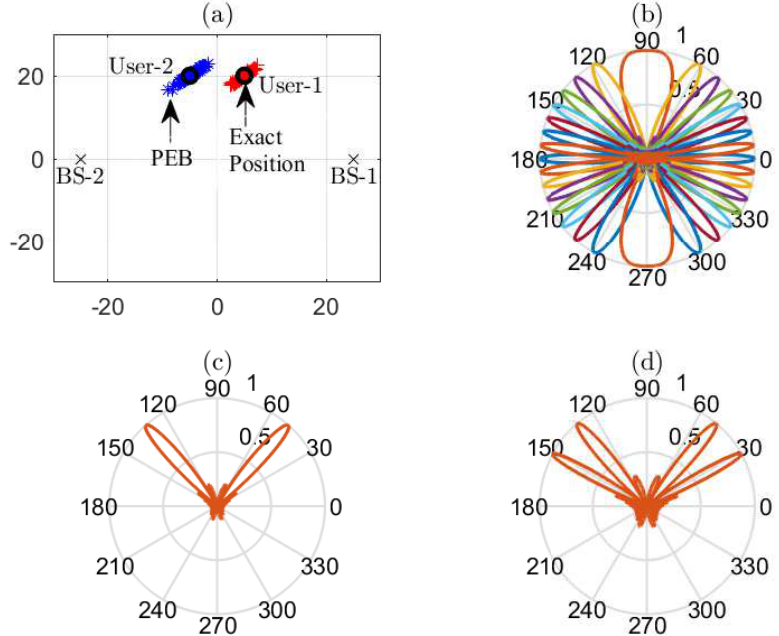
Figure 3. An example system model with: ( a ) communication system with |B| = 2, |K| = 2 with exact user’s location and corresponding PEB; ( b ) receive beamforming codebook W b ∀ b with cardinality |W | = 16; ( c ) receive beamforming w ( 1 ) for BS-user pair ( 1,1 ) for the non-cooperation scenario; and b 1 ( d ) compromise superposition receive beam ¯w 1 at